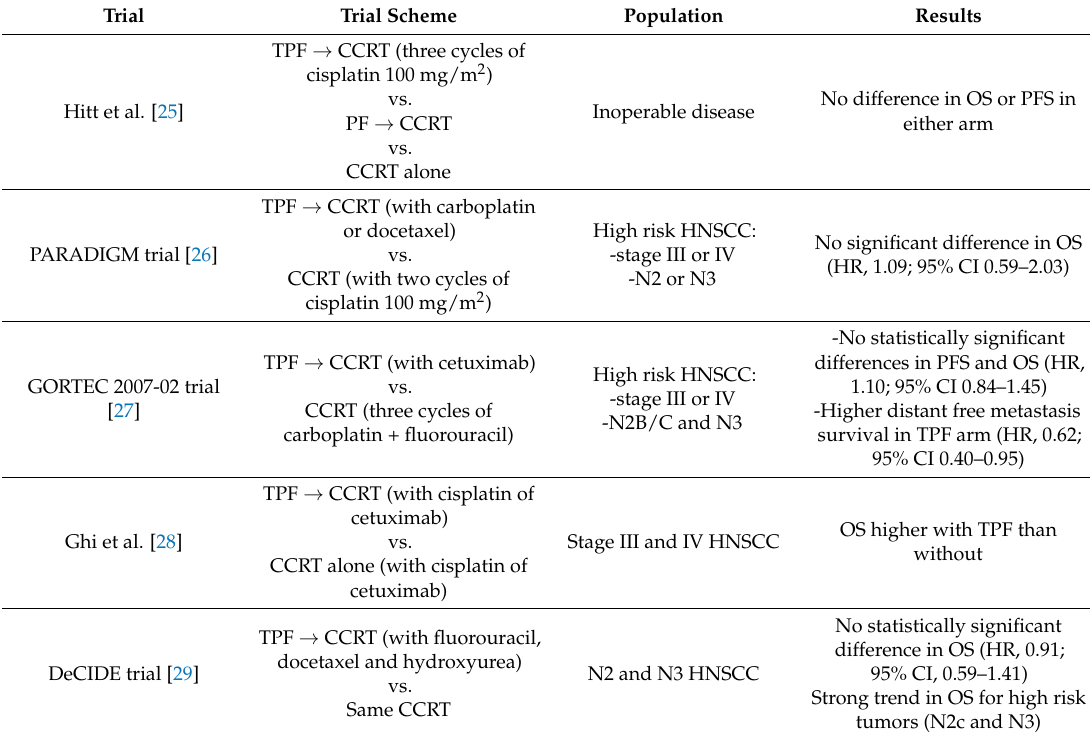
Table 4. Direct comparisons between Induction chemotherapy and concomitant chemoradiotherapy in unresectable disease HR: hazard